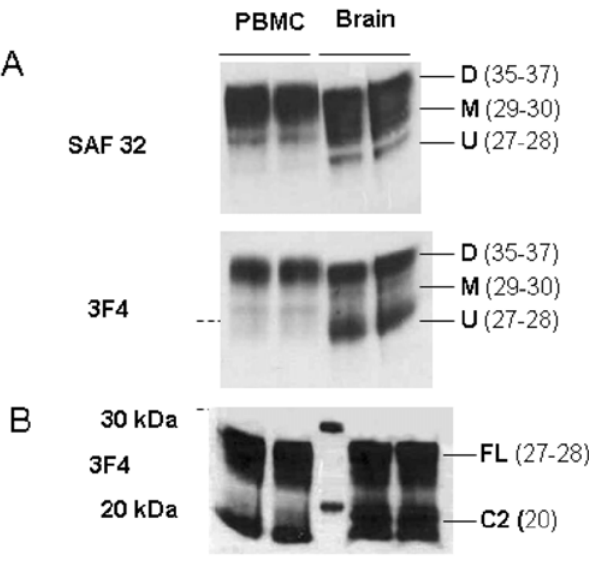
Figure 3. Comparative biochemical analysis between brain and PBMCs. A) Immunoblots of PrP C glycoforms from PBMCs and brain, Denatured lysates from 10 6 PBMCs and 10% brain were tested by Western Blot analysis using 2 antibodies: SAF32 (79–91), 3F4 (109–112). The 35–37 kDa band corresponds to the M.W. of the diglycosylated protein (D), while the 29–30 kDa and 27–28 kDa bands correspond to the M.W. of the monoglycosylated (M) and the unglycosylated (U) proteins, respectively. B) Immunoblots of truncated proteins from PBMCs and brain, After PNGase treatment, denatured lysates from 10 6 PBMCs and brain were tested by Western Blot analysis using 3F4 (109– 112). The 27–28 kDa bands correspond to the M.W. of the unglycosy- lated Full-Length (F.L.) protein while the band near 20 kDa corresponds to the C2 fragment.